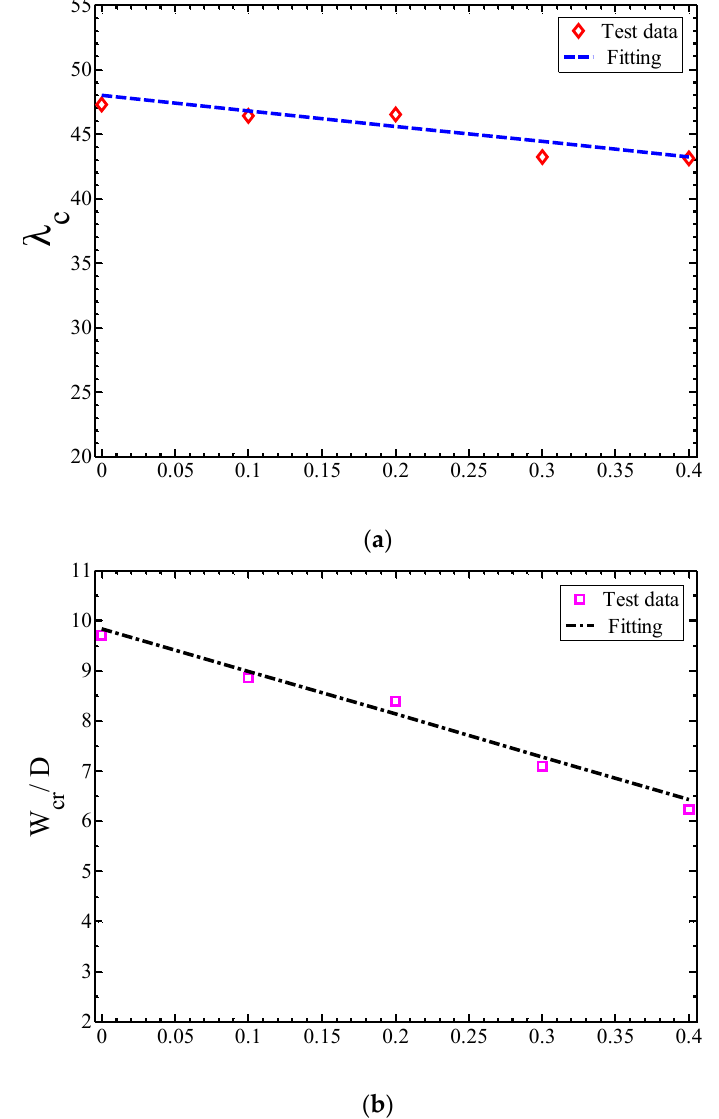
λ W ) for strand cables with var- ) and ( b ) failure displacement ( cr